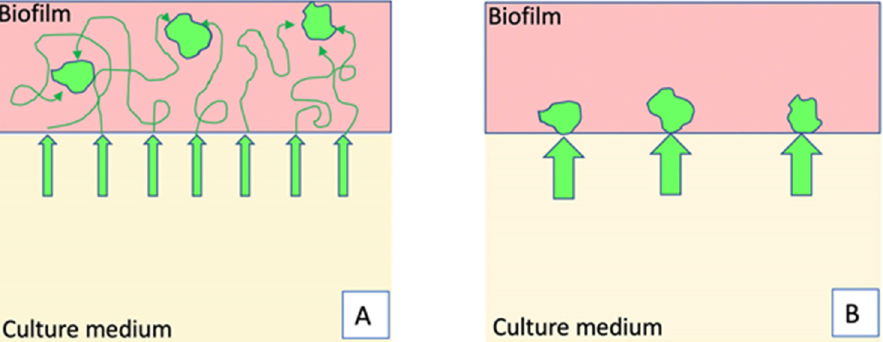
Figure 7. Hypotheses to explain the integration of planktonic cells in specific areas of the biofilm. ( A ): Planktonic cells enter deeply in the pellicle, are motile, and settle in suitable areas. ( B ): Planktonic cells enter the pellicle directly in specific spots, located at the biofilm lower